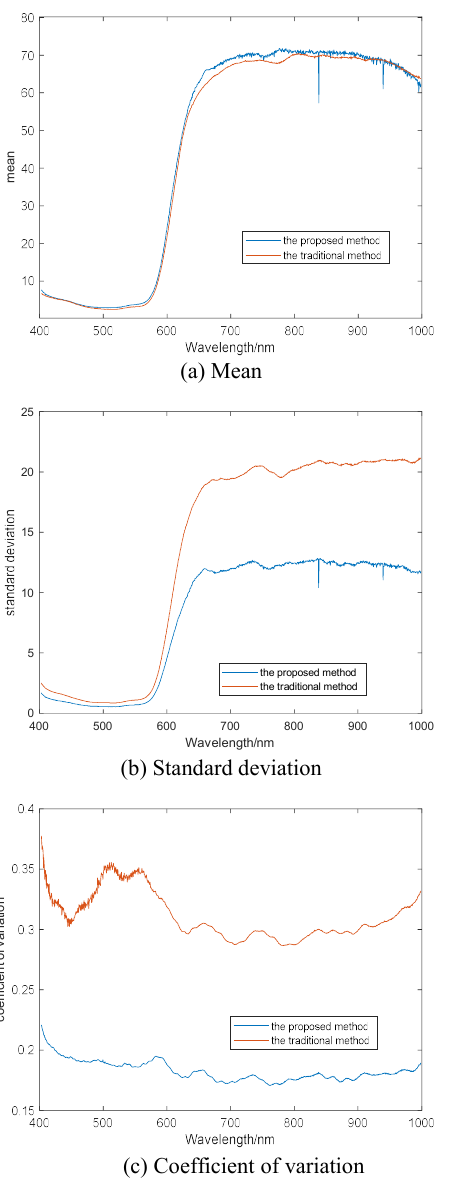
Figure 5. The statistics result of hyperspectral image